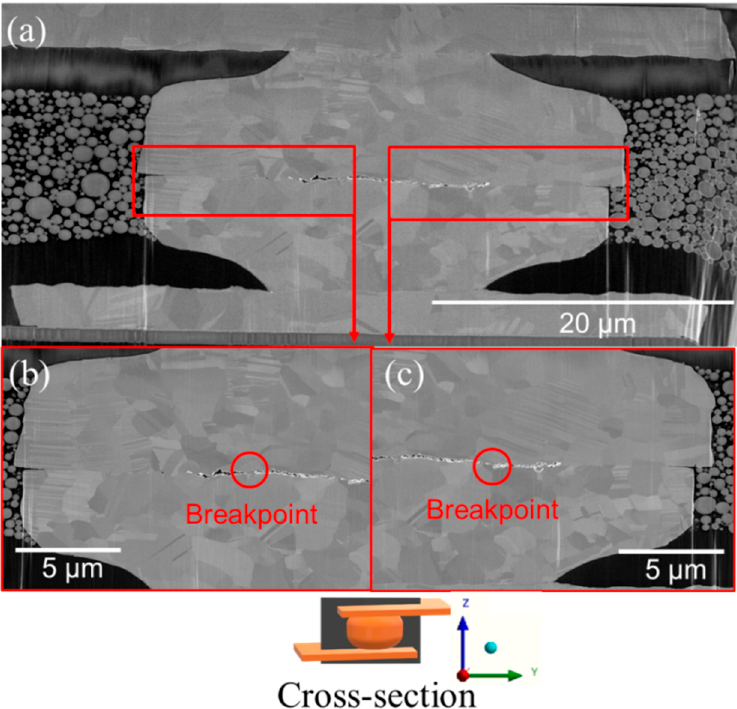
Figure 5. ( a ) Cross-sectional FIB image of the joints after 1000 thermal cycles at a high cycling temperature (300 °C). ( b , c ) The enlarged images of ( a ) showing various voids and breakpoints in the bonding interface.